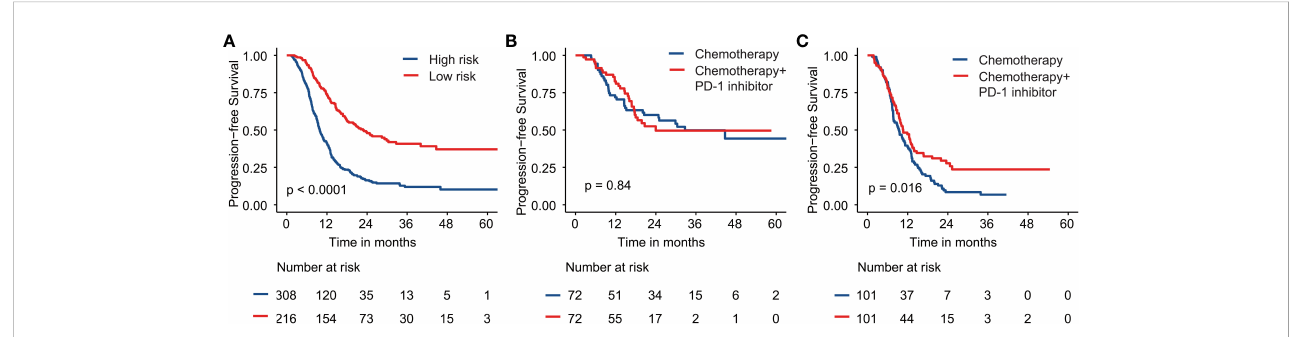
FIGURE 3 Kaplan – Meier survival curves are shown for progression-free survival for (A) high and low-risk groups; (B) the low-risk group with chemotherapy plus PD-1 inhibitor or chemotherapy alone; (C) the high-risk group with chemotherapy plus PD-1 inhibitor or chemotherapy